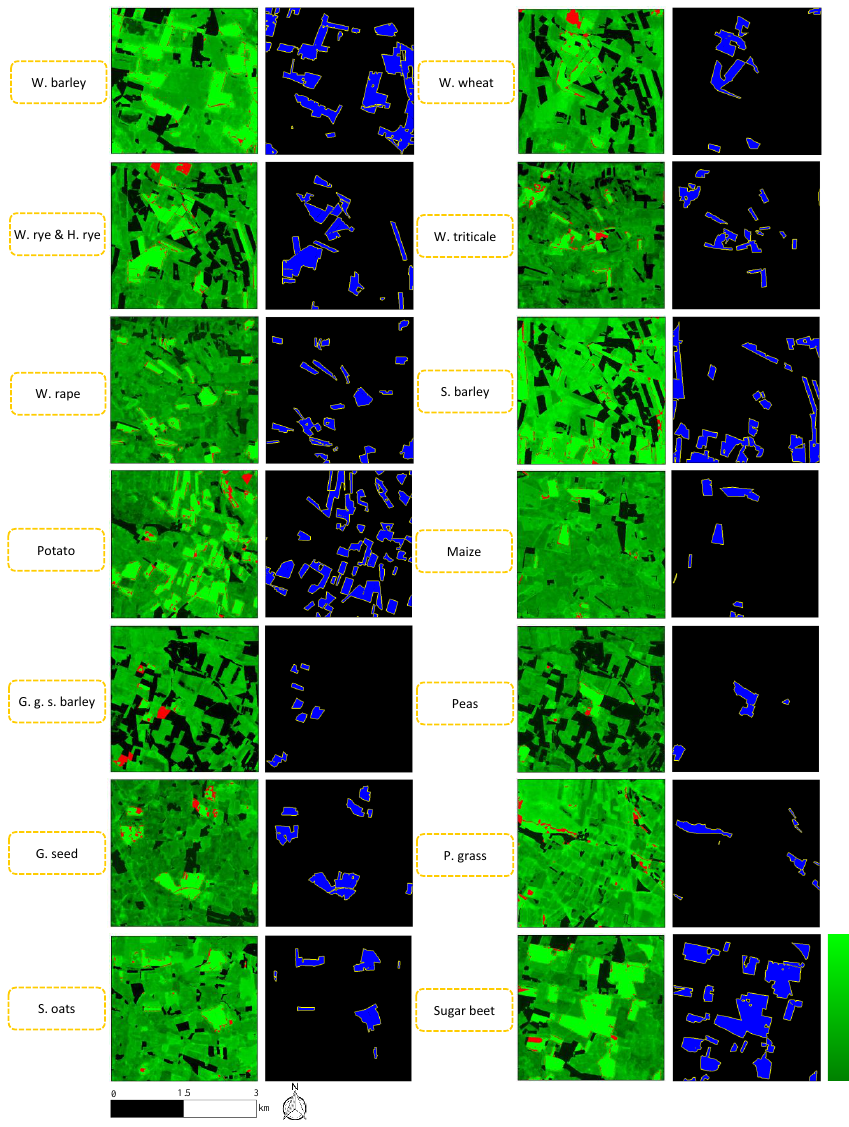
Figure 11. Classification confidence of the proposed method. Red pixels and blue regions correspond to the error and label images, respectively. The green color bar shows the confidence of our approach for each crop